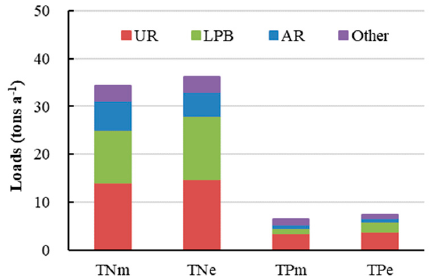
Figure 6. Annual average simulated results of the NPS pollution emissions into rivers from the combined model and the export coefficient model. TNm and TPm are the simulation results using the combined model, and TNe and TPe are the results using the export coefficient model.